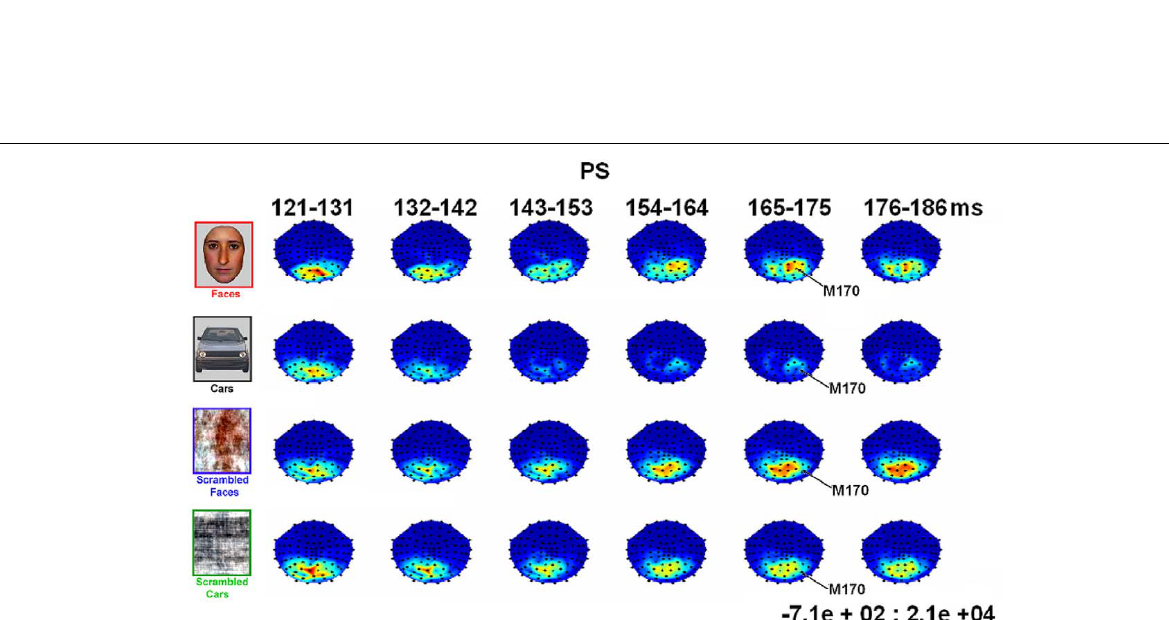
FIGUREA6 | Evolution of magnetic fields evoked by visual stimulation as calculated from the root-mean-square (RMS) of signals recorded by each of the two orthogonal planar gradiometers at the 102 locations for patient PS averaged across 10ms time windows around the M170